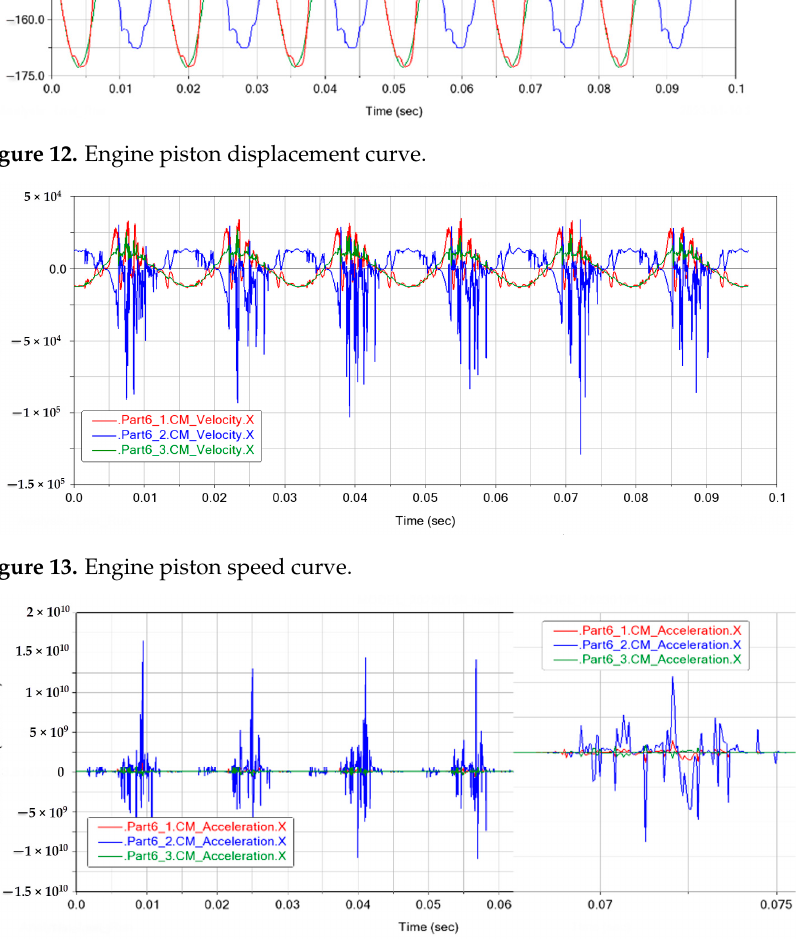
Figure 14. Engine piston acceleration diagram.